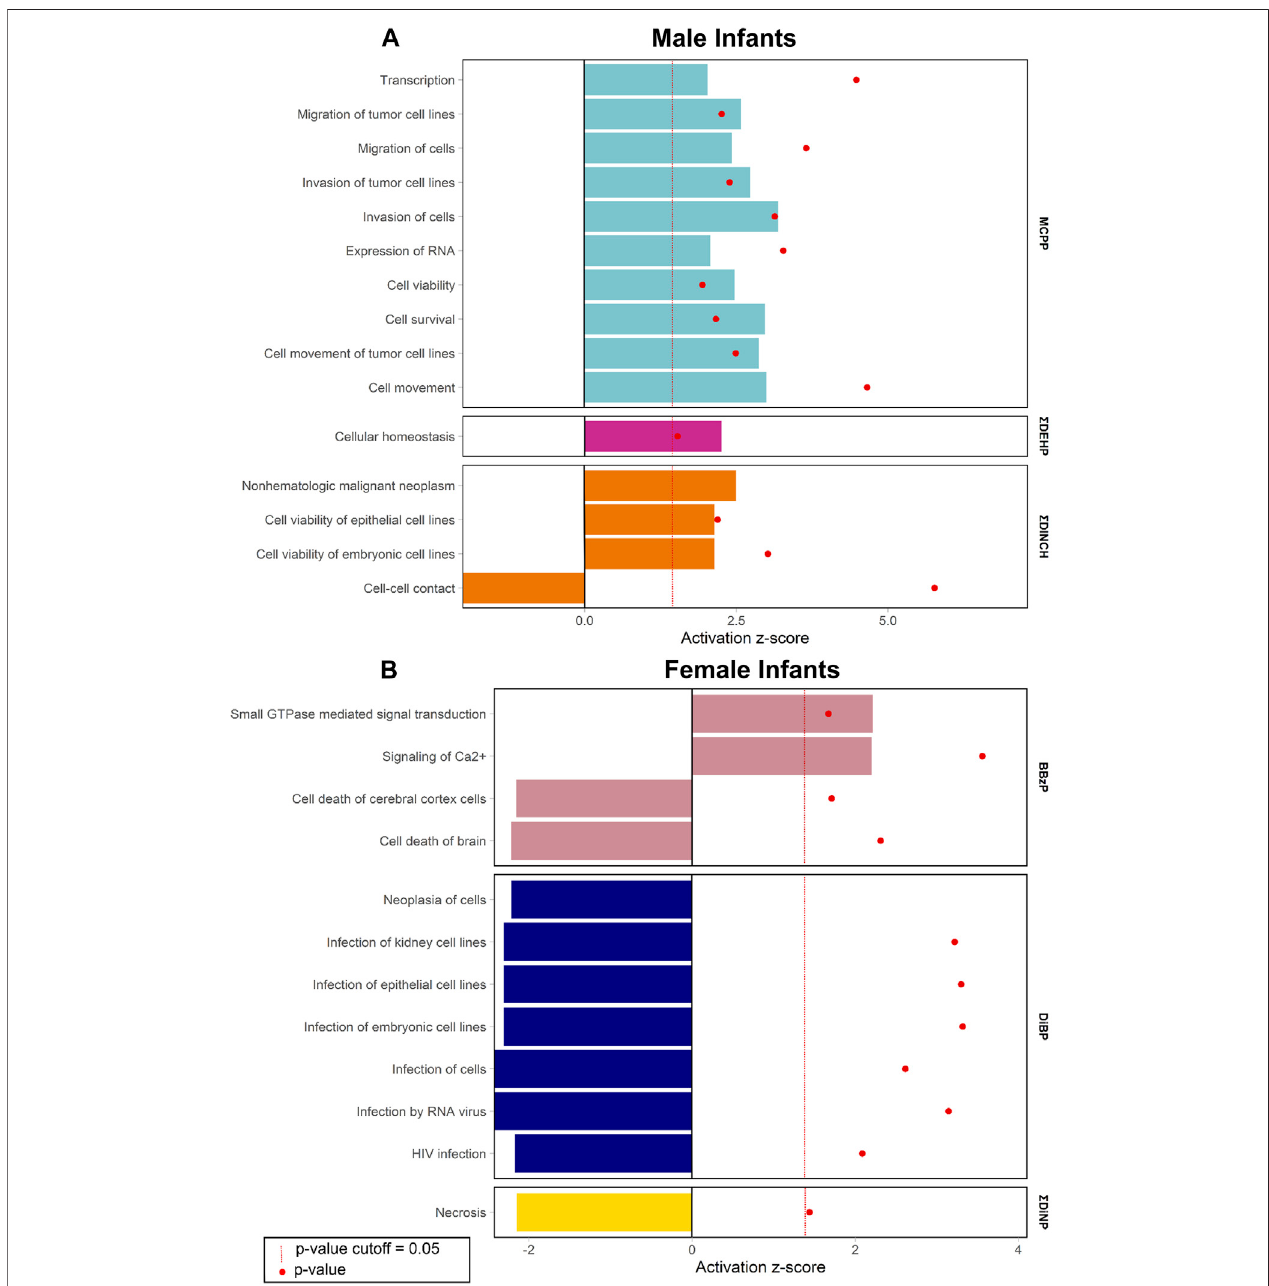
FIGURE 4 | Signi fi cantly enriched pathways from the IPA Functions by infant sex. Top panel (A) shows results from males, bottom panel (B) shows results from females. Using CpG loci with a raw p -value < 0.001, the % of genes enriched in each pathway are reported by individual phthalate or phthalate alternative. Only human pathways with a p < 0.05 and a z -score > |2| from the pathway analysis are included in the fi gures. Full gene lists can be found in Supplement 6.